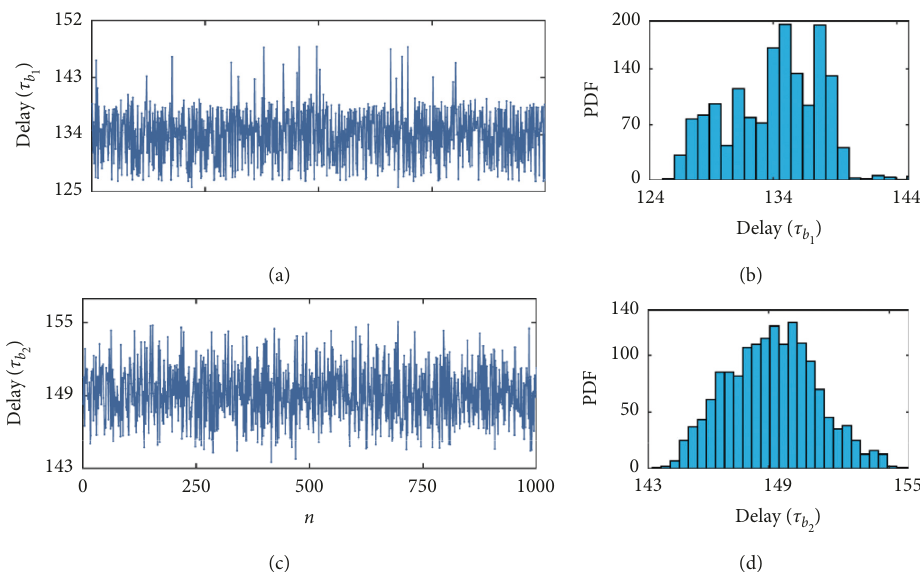
Figure 2: Bifurcation delay of consecutive periodic cycles for (a) first bifurcation delay τ are the corresponding probability distribution of both the bifurcation delays. Here, the average mean bifurcation delay is (a) τ b (b) τ b 149. Other parameter values are fixed same as in Figure 1. 2 (cid:29)